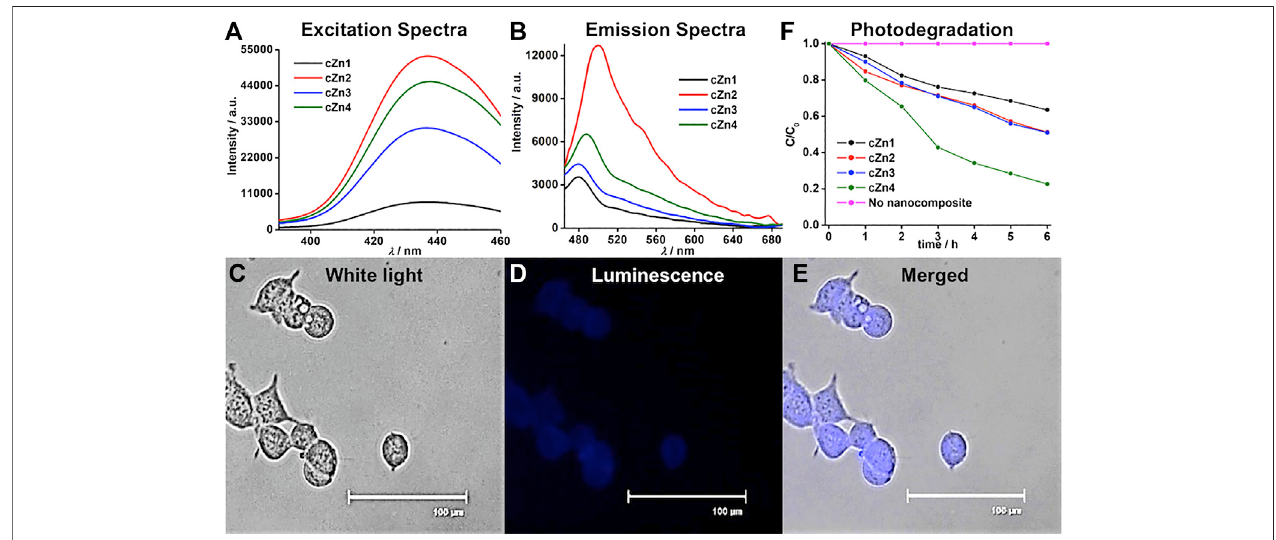
FIGURE 4 | (A) Excitation, (B) emission spectra of nanocomposites cZn1 - cZn4 , (C – E) imaging of cZn2 in HEK293 cells, where cells were excited at 390/40 nm and emissionsweremonitored with446/33blue fi lterforluminescenceimage, scalebar:100 μ m, (F) photodegradationofrhodamine-Binpresenceofnanocomposites cZn1 - cZn4 .